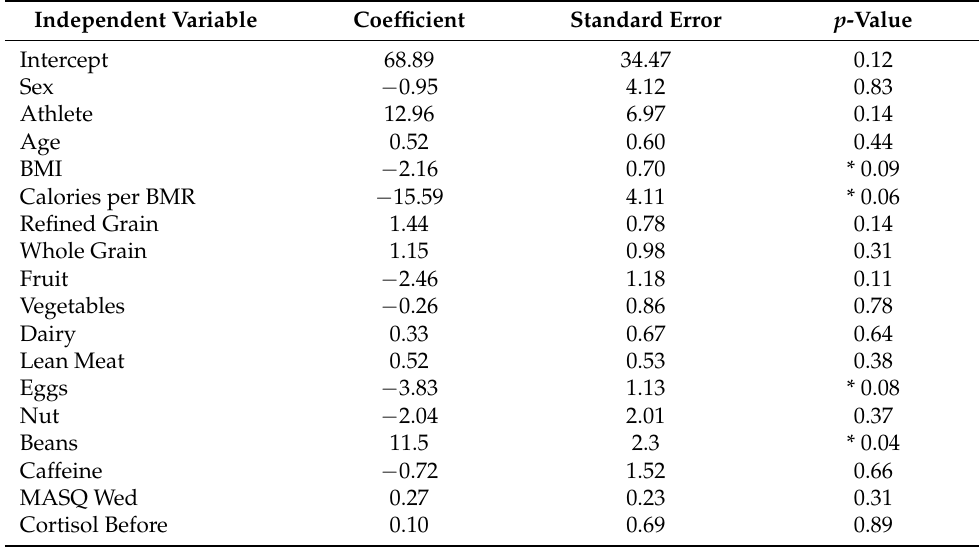
Table 13. Regression results of MASQ Saturday scores (dependent variable) and sex, age, BMI, athlete, calories per BMR, cortisol level before exercise, MASQ scores on Wednesday, refined grain, whole grain, fruit, vegetables, dairy, meat, eggs, nuts, beans, and caffeine (independent variable). * p < 0.1. Independent